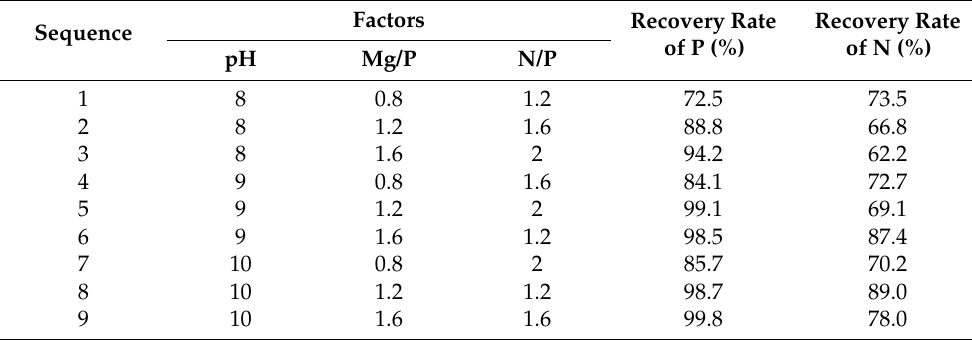
Table 2. Results analysis of the orthogonal